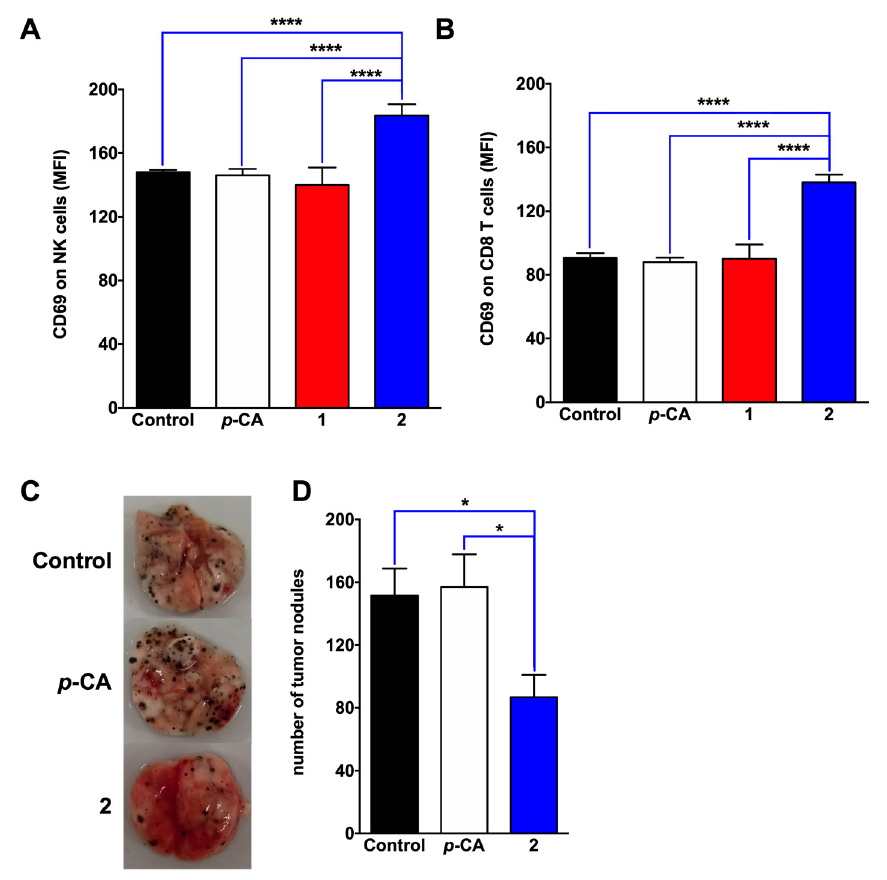
Figure 5. N -butyl p -coumarate stimulates the NK and CD8 T cell activation and controls the tumor growth. ( A , B ): splenocytes from C57BL/6 were incubated with p -coumaric acid ( p -CA, white), ethyl p -coumarate ( 1 , red) or n-butyl p -coumarate ( 2 , blue) at 0.1 mM for 6 h and the CD69 expression was analyzed by flow cytometry in the NK ( A ) and CD8 T ( B ) cells. The figure represents mean ± SD of one single experiment (n = 5/group). C-D: C57Bl/6 mice were injected i.p. with a saline solution containing p -CA or compound 2 (2 mg/animal) for 5 consecutive days. Control animals received the corresponding DMSO concentration. At day three of the treatment, 2 × 10 5 B16-F10 melanoma cells were inoculated i.v., and the number of tumor nodules was assessed fifteen days later. ( C ) representative figure from one animal/group. ( D ) The figure represents the mean ± SEM of the lung nodule counts from two individual experiments (n = 4–5/group). * p < 0.05. **** p <